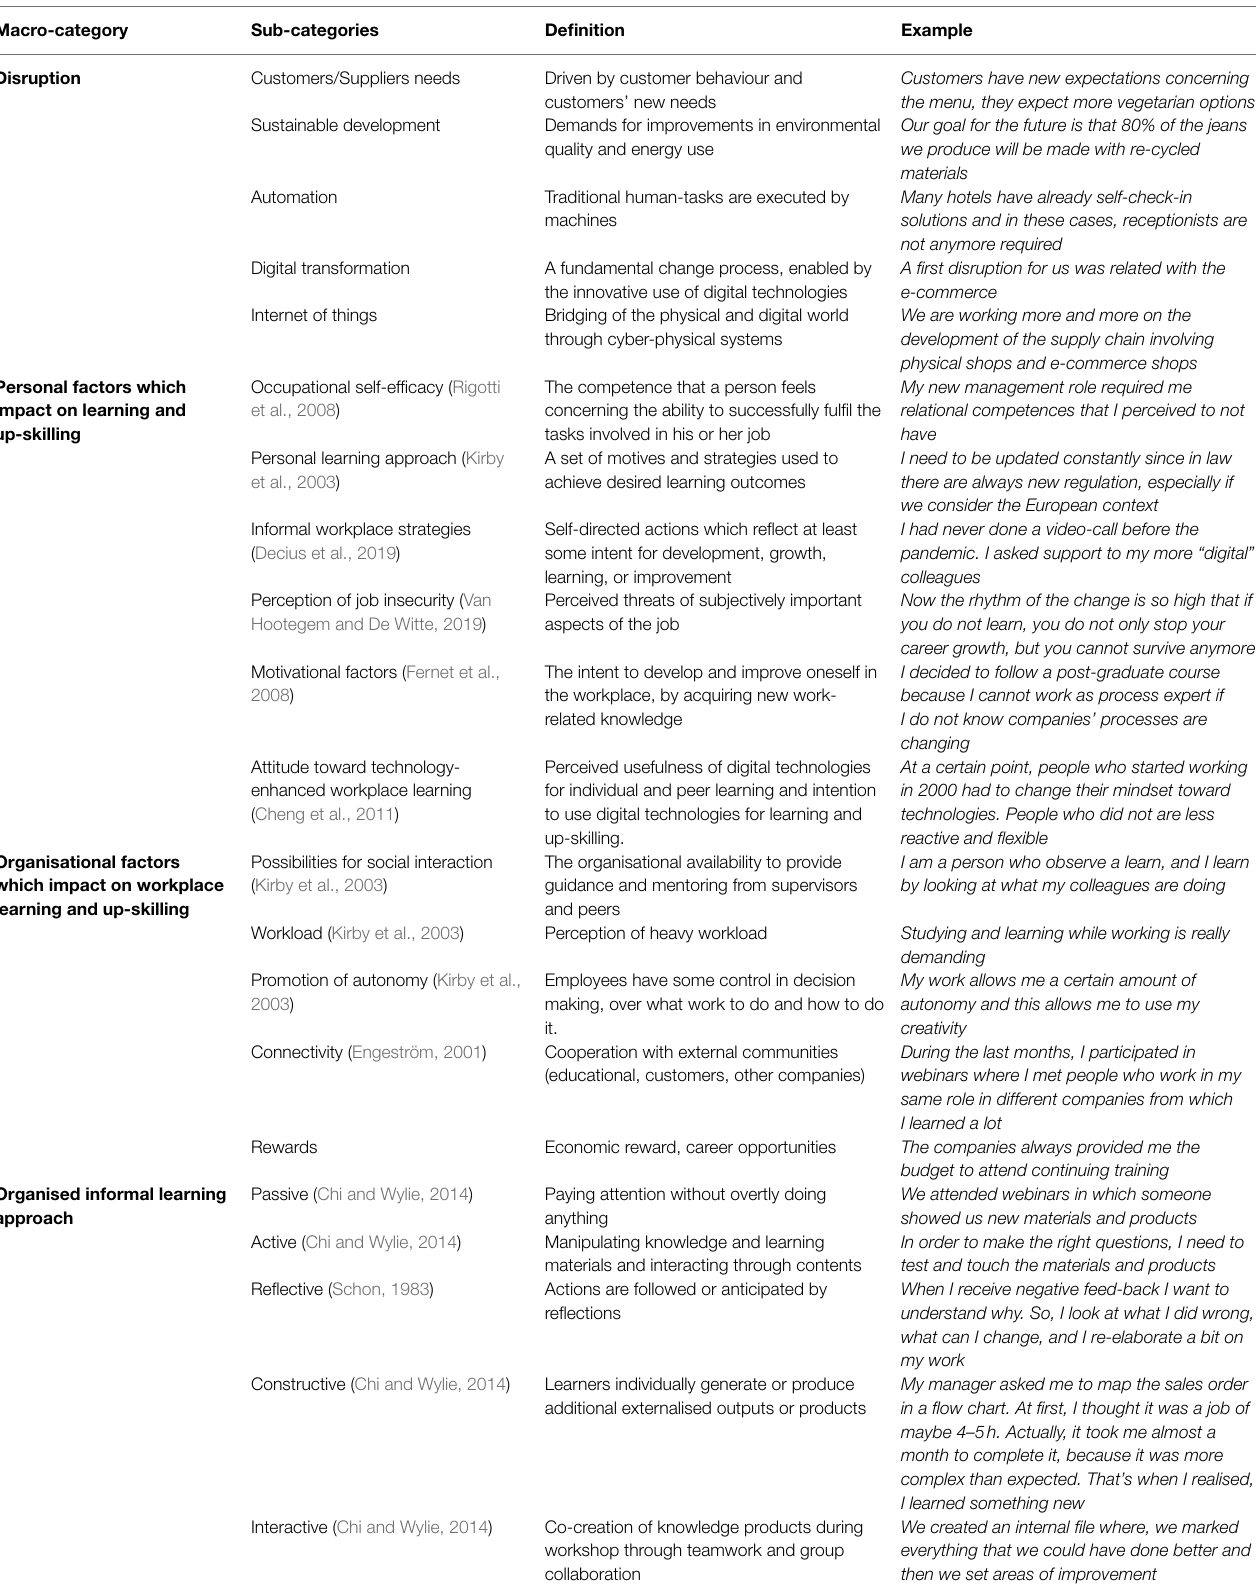
TABLE 4 | Coding scheme for the qualitative content